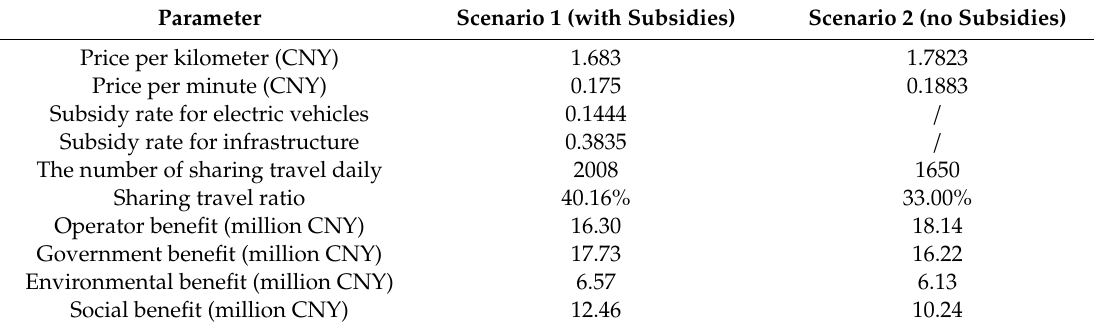
Table 2. Equilibrium solution and the benefits of each participant in two scenarios.